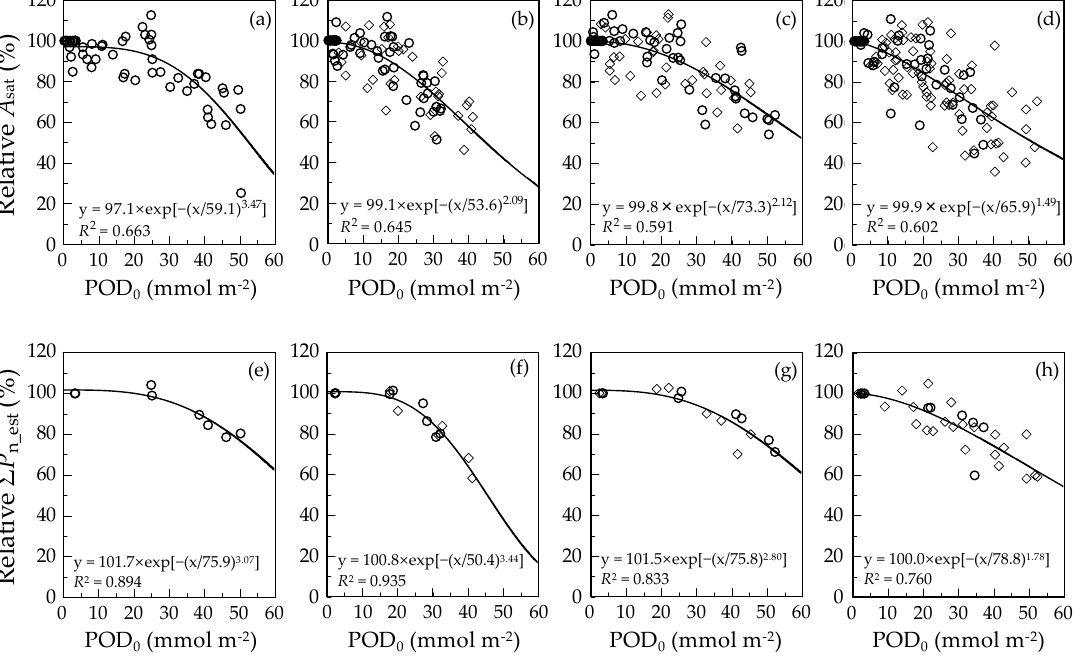
Figure 2. Relationships between relative A sat ( a – d ) or Σ P n_est (e–h) and POD without flux threshold (POD 0 ) in the leaves of F. crenata ( a , e ), Q. serrata ( b , f ), Q. mongolica var. crispula ( c , g ) and B. platyphylla var. japonica ( d , h ). Open circles indicate 1st flush or early leaves, and open diamonds indicate 2nd flush or late leaves. The Weibull function was fitted to the response, and the coe ffi cient of determination ( R 2 ) is indicated in each figure. Data in ( a )–( d ) were from Table S2 (POD 0 ) and S7 ( A sat ), and in ( e )–( h ) were from Table S4 (POD 0 and Σ P n_est ).